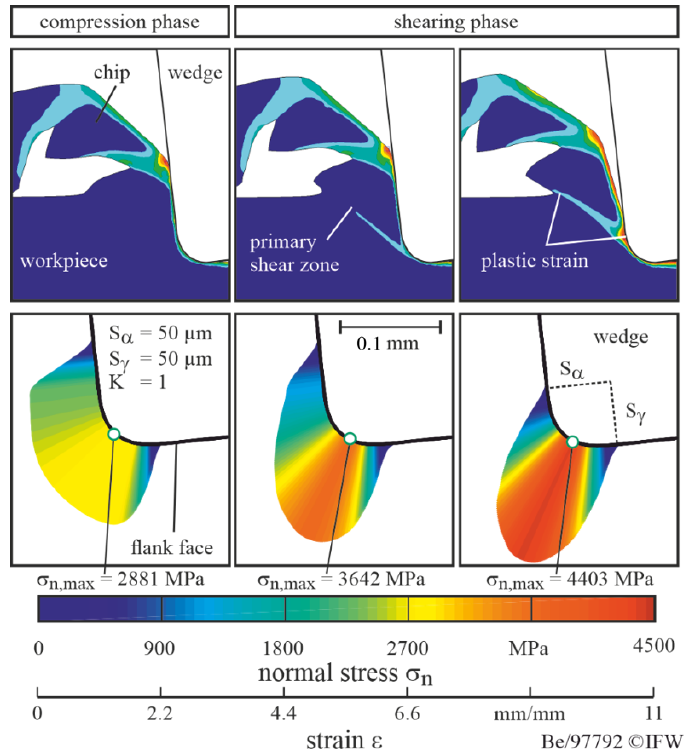
Figure 9. Phases of segmented chip formation and corresponding normal stress distribution during machining of TiAl6V4.